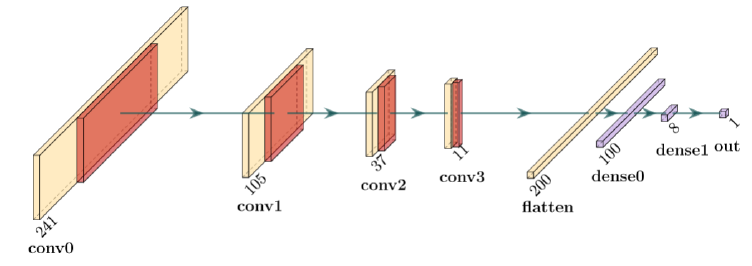
Figure 4. Diagram of the proposed CNN